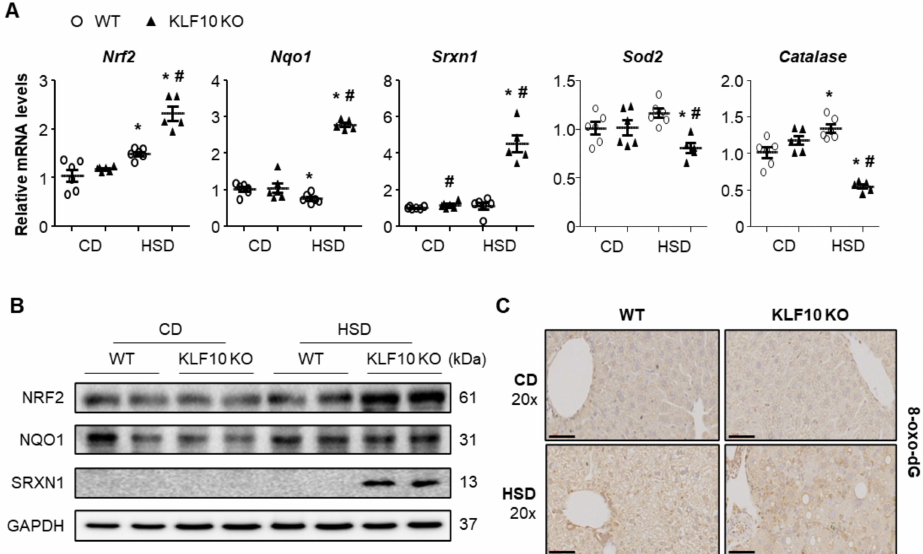
Figure 3. Klf 10 deletion induces oxidative stress upon high-sucrose feeding. Eight-week-old WT and Klf 10 KO mice were fed either CD or HSD for eight weeks ( n = 5–6 mice/group). Changes in hepatic mRNA and protein expression involved in oxidative stress response were analyzed via ( A ) qPCR and ( B ) Western blotting. Antioxidant genes ( Nrf2 , Nqo1 , and Srxn1 ) and ROS scavenger genes ( Catalase and Sod 2) were analyzed. Target gene expression was normalized to the expression of Rplp0 . ( C ) Representative 8-oxo-2 (cid:48) -deoxyguanosine (8-oxo-dG)-stained livers (Scale bars: 60 µ m, Magnification: 20 × ). All data are representative of at least three independent experiments and expressed as mean ± SEM. Charts were produced using GraphPad Prism 5.0. Statistical differences were determined by two-way ANOVA with Mann–Whitney U test using SPSS v17.0. * p < 0.05 vs. genotype-matched, CD-fed group and # p < 0.05 vs. diet-matched, genotype control. WT, wild type; KO, knockout; CD, control chow diet; HSD, high-sucrose